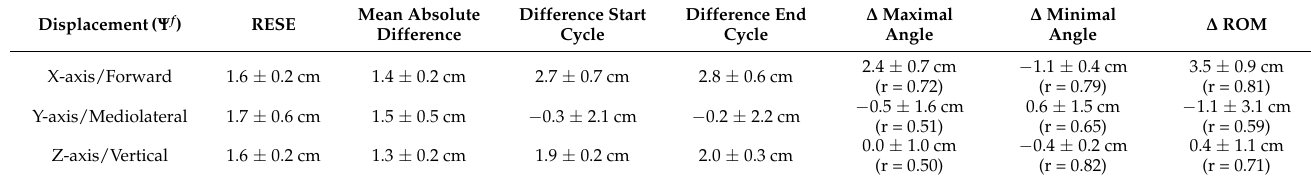
Table 2. Mean displacement differences between DFOD and OMCS for all subjects combined. RMSE refers to the root mean square difference in 3D sensor and cluster displacement. “Difference start cycle” and “Difference end cycle” refer to the difference between DFOD and OCMS (OMCS-DFOD) at the first and last sample of the gait cycle. “ ∆ Maximal displacement” and “ ∆ Minimal displacement” refer to the differences in the estimated maximal and minimal displacement during each gait cycle between DFOD and OMCS (OMCS-DFOD). “ ∆ ROM” refers to the mean differences in the estimated range of motion during each gait cycle for DFOD and OMCS. Pearson correlation coefficients (r) are provided between brackets.